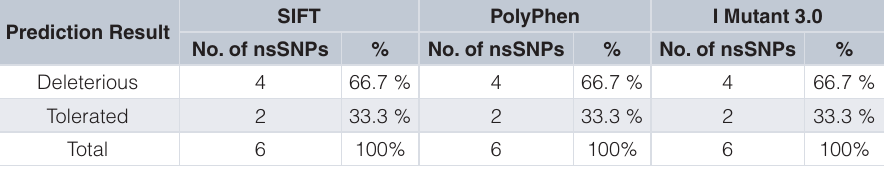
Prediction Result